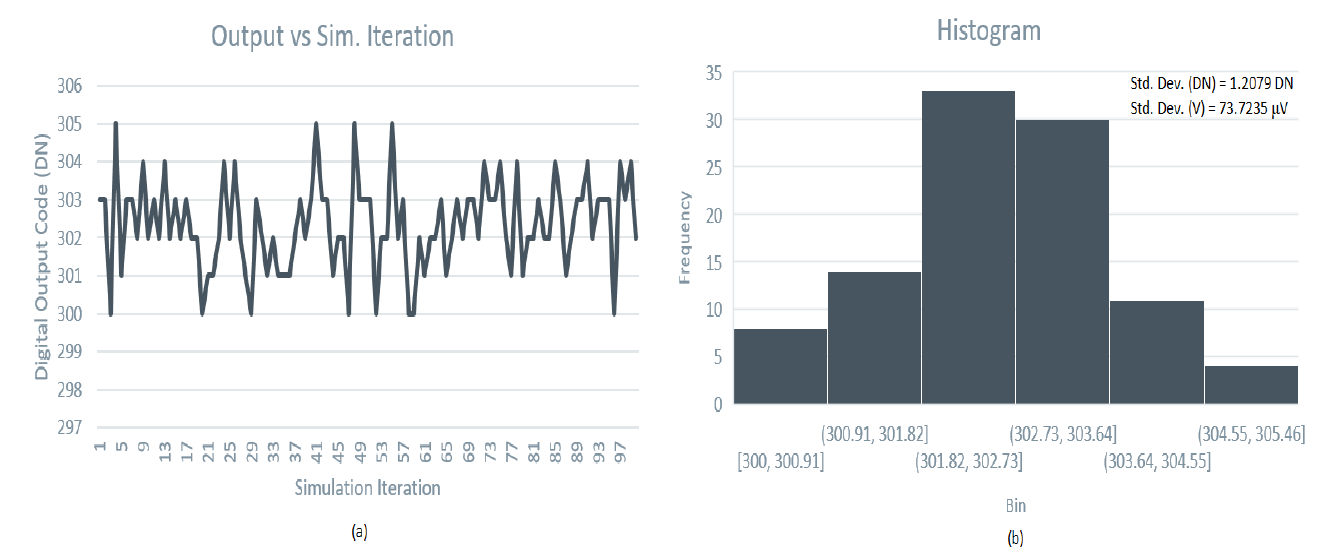
Figure 16. All readout circuit chain (Pixel, PGA and ADC)—Transistor level Transient-Noise simulation. Total output noise measurement under an Analogue CDS operation at the PGA stage and under a Digital CDS operation within the ADC stage. ( a )—Output digital codes as a function of the simulation run (equivalently the full readout noise performance in the dark); ( b )—the corresponding digital output codes occurrence frequency through a histogram.